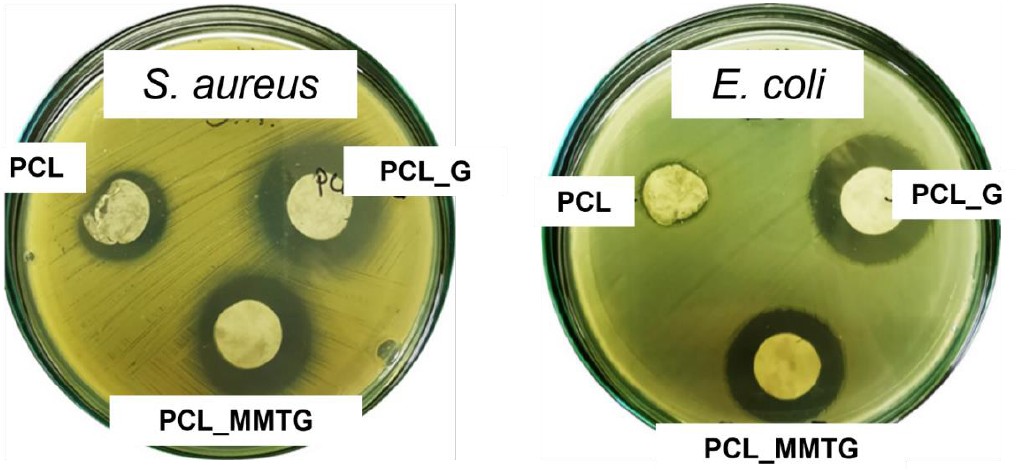
Figure 7. Antimicrobial tests results of PCL, PCL_G and PCL_MMTG materials against S. aureus and E. coli . Table 6. Growth inhibition zones [mm] around the tested nonwovens after contact with Gram- positive ( S. aureus ) and Gram-negative ( E. coli ) bacteria.